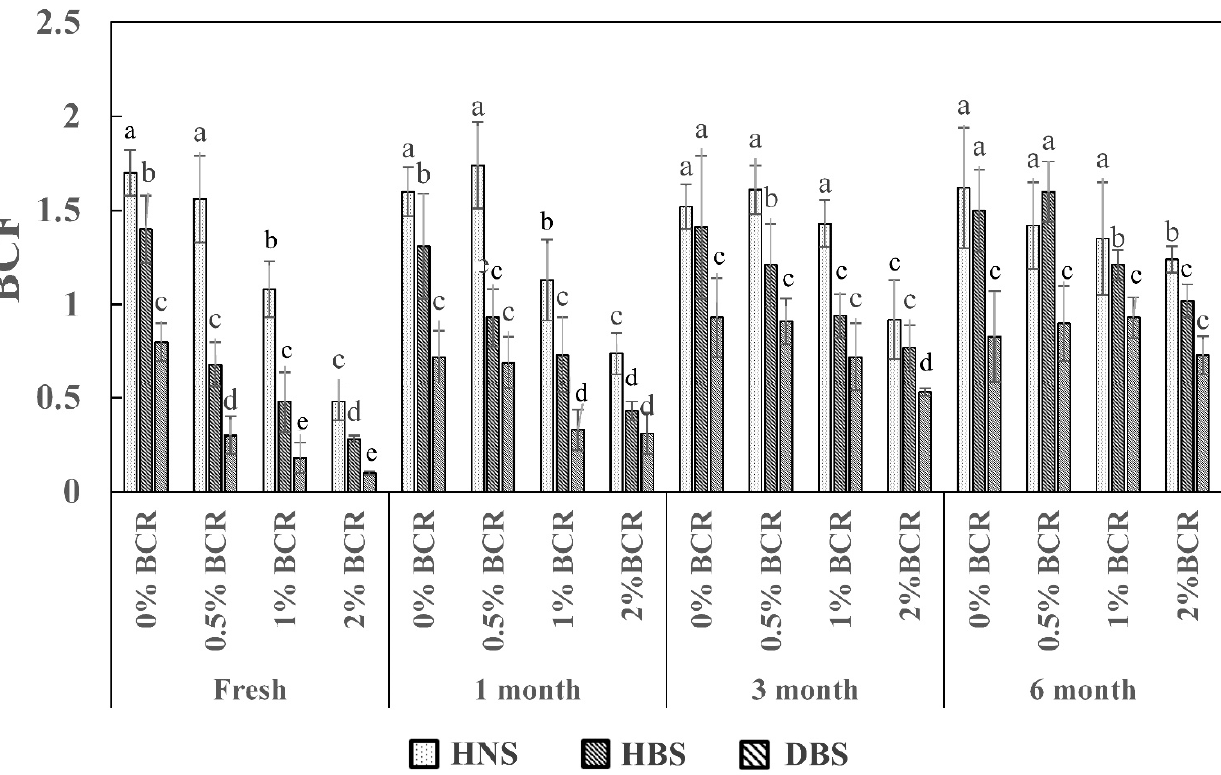
Figure 2. Bioaccumulation factor (BCF) of earthworms in three types of soils with biochar (BCR) after aging treatment. Data are expressed as the mean values ± SE (standard error). Different letters indicate significant differences among the treatments (two-way ANOVA, Tukey’s HSD, p < 0.05).